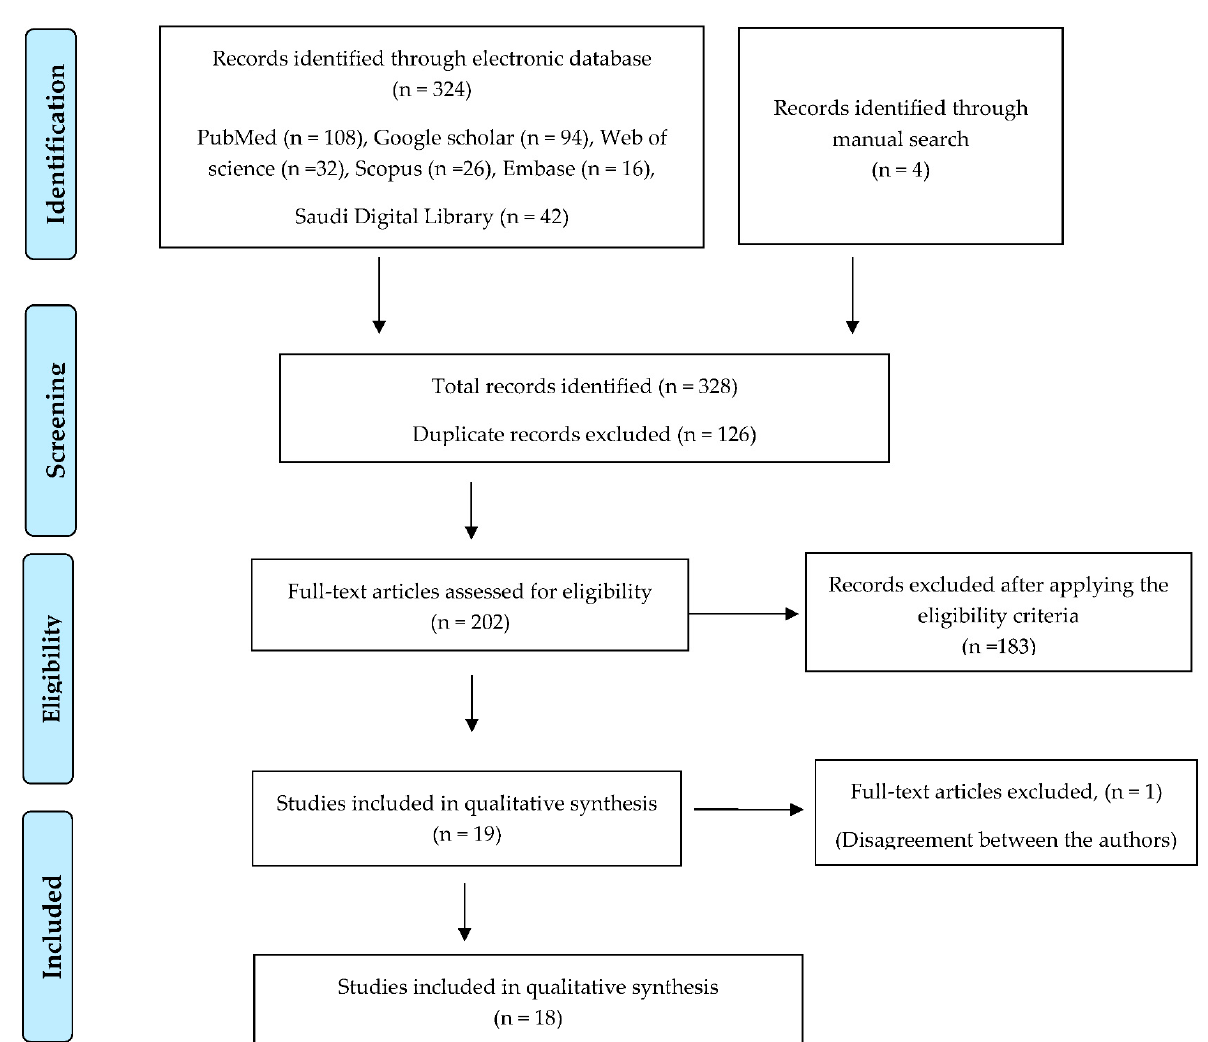
Figure 1. Flow chart for screening and selection of articles.